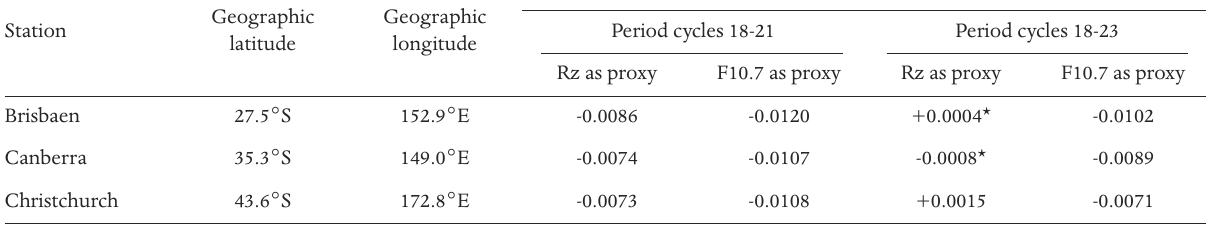
Table 1. Geographic coordinates of the Southern Hemisphere ionospheric stations here analyzed and linear foF2 trend in MHz/year cal- culated for four different conditions: filtering seasonal and solar activity effects using Rz (4th and 6th columns) and F10.7 (5th and 7th columns), and for periods covering solar cycles 18 to 21 (4th and 5th columns) and 18 to 23 (6th and 7th columns) (values with * mean not significantly different from